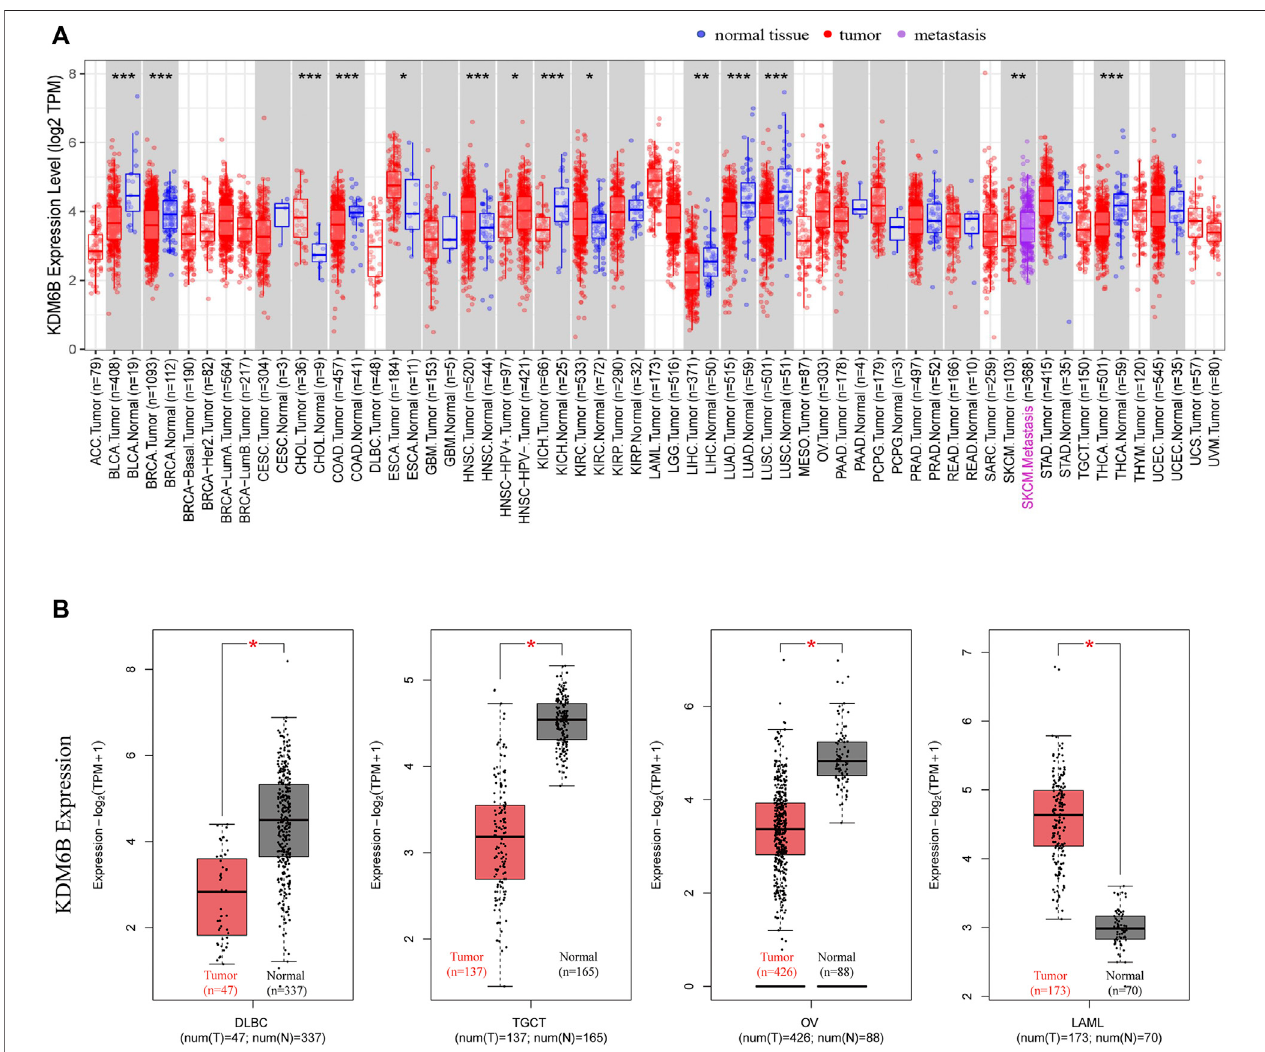
FIGURE 1 | Expression of KDM6B in different tumors. (A) Expression status of KDM6B in different cancers or speci fi c cancer subtypes was analyzed through TIMER2. * p < 0.05; ** p < 0.01; *** p < 0.001. (B) For the types of DLBC, LAML, OV, and TGCT in the TCGA project, the corresponding normal tissues from the GTEx database were included as controls. The box plot data were supplied. * p <